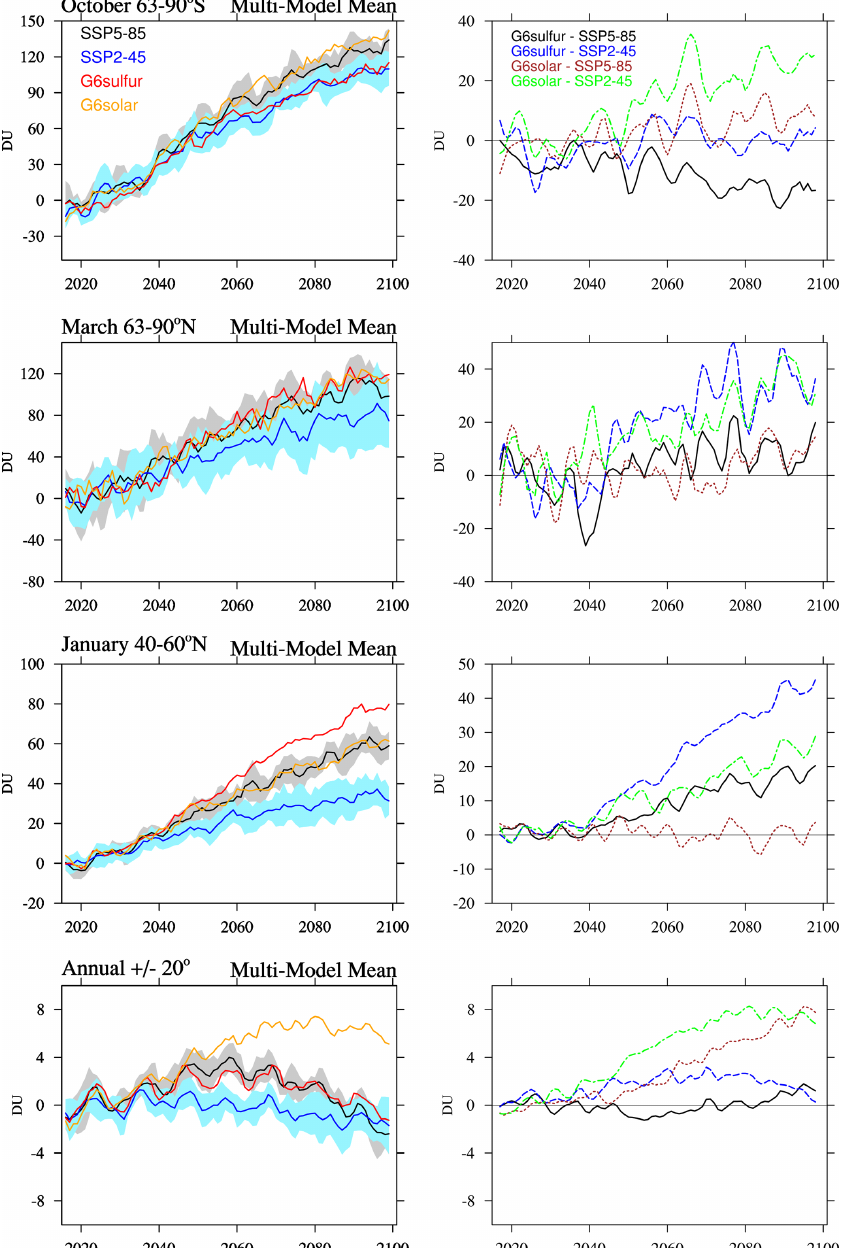
Figure 11. The left column shows the multi-model mean of the total column ozone evolution between 2020 and 2100 normalized to 2020 values for different experiments (different colors) and four different regions and seasons (different rows). The 2 σ standard deviation of the ensemble mean is only shown for SSP5-8.5 and SSP2-4.5 scenarios for better readability. The right column shows the differences between G6sulfur and SSP5-8.5 (black lines), G6sulfur and SSP2-4.5 (blue lines), G6solar and SSP5-8.5 (brown lines), and G6solar and SSP2-4.5 (green lines) for the multi-mean of total column ozone between 2020 and 2100 for four different seasons and regions (different